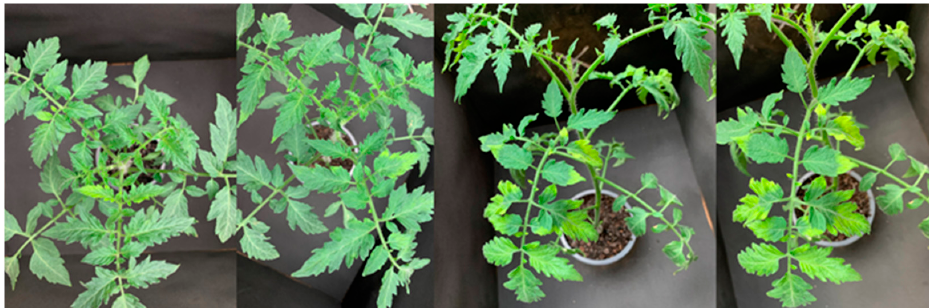
Figure 14. The e ff ects of simulated diuron drift with a close-up view show injuries in tomato plants.